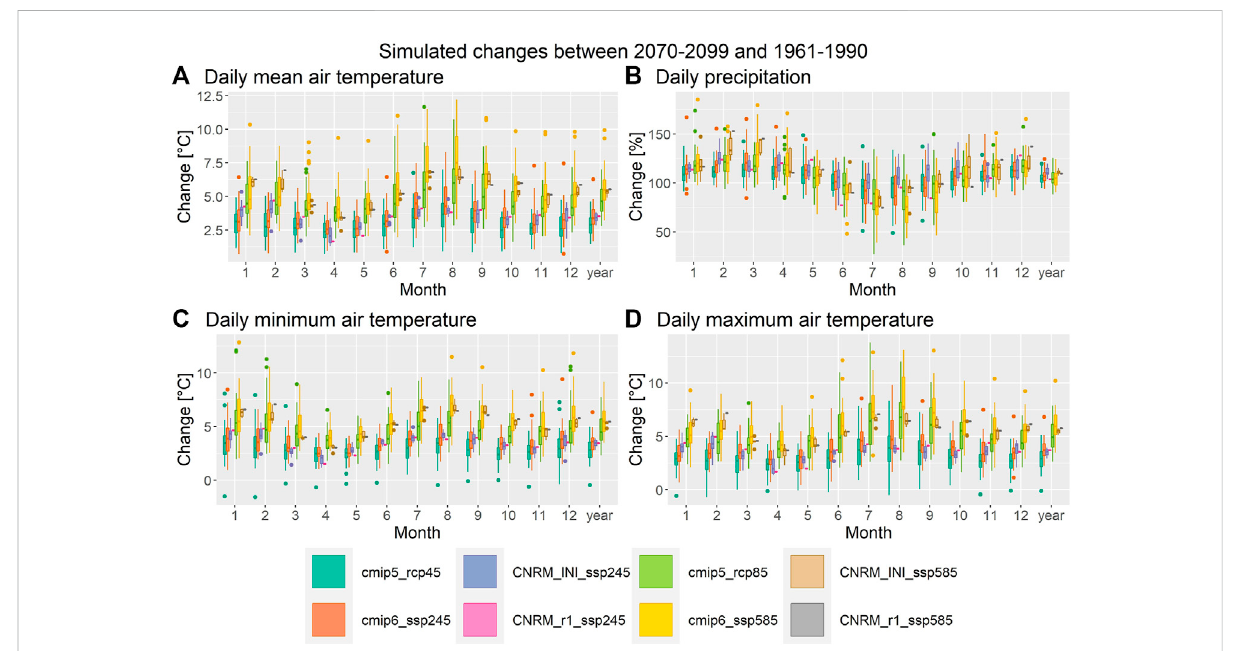
FIGURE 4 Projected changes of monthly means of daily mean air temperature (A) , daily precipitation amount (B) , daily minimum air temperature (C) and daily maximum air temperature (D) for the period of 2070 – 2099 in comparison to 1961 – 1990 averaged over the area of the Czech Republic, “ year ” denotes annual mean change. Boxplots show intra-ensemble statistical distribution (median, lower and upper quartiles, whiskers representing 1.5 * IQR, and outliers as dots) of CMIP5 under RCP4.5 (dark green), CMIP6 under SSP2-4.5 (orange), perturbed initial conditions mini-ensemble of CNRM-ESM2-1 GCM under SSP2-4.5 (10 members, blue), CMIP5 under RCP8.5 (light green), CMIP6 under SSP5-8.5 (yellow), perturbed initial conditions mini-ensemble of CNRM-ESM2-1 GCM under SSP5-8.5 (5 members, brown). The CNRM-ESM2-1 r1i1p1f2 simulation is plotted as a pink line for SSP2-4.5 and as grey line for